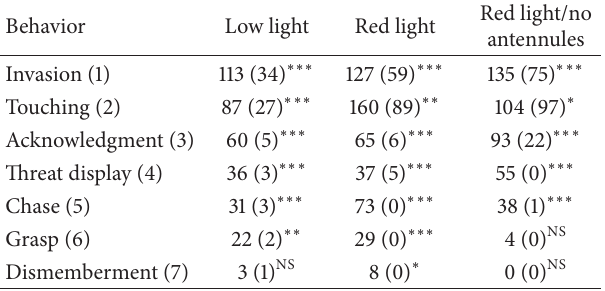
Table 4: Total number of social interaction across study conditions for blind crayfish. Social interactions were observed both “in water” and “out of water.” Each row corresponds to the total number of interactions for a given behavioral score. Each column corresponds to an environmental